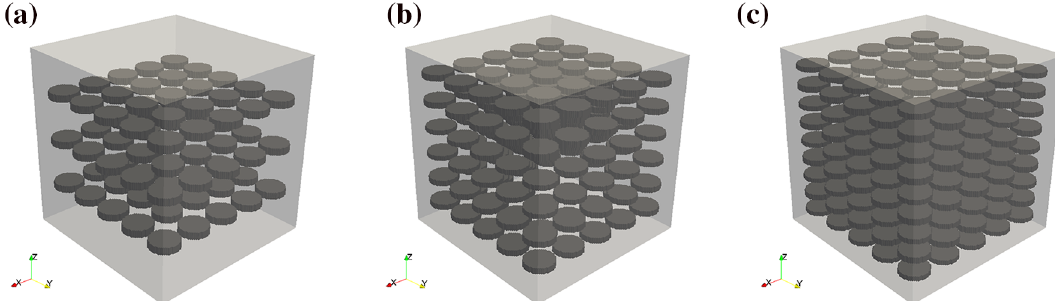
Fig. 1 Virtual specimens with different arrangements of anisotropic insulations: a L3 sample with 3 insulation layers (total of 75 insulations), b L6 sample with 6 layers (150 insulations), c L9 samples with 9 layers (225 insulations) [In the figure, the dark gray voxels represent anisotropic insulations. Each coin-shaped insulation has the same dimension, and each insulation layer is composed of 25 insulations (5 (cid:2) 5 in (cid:2) y